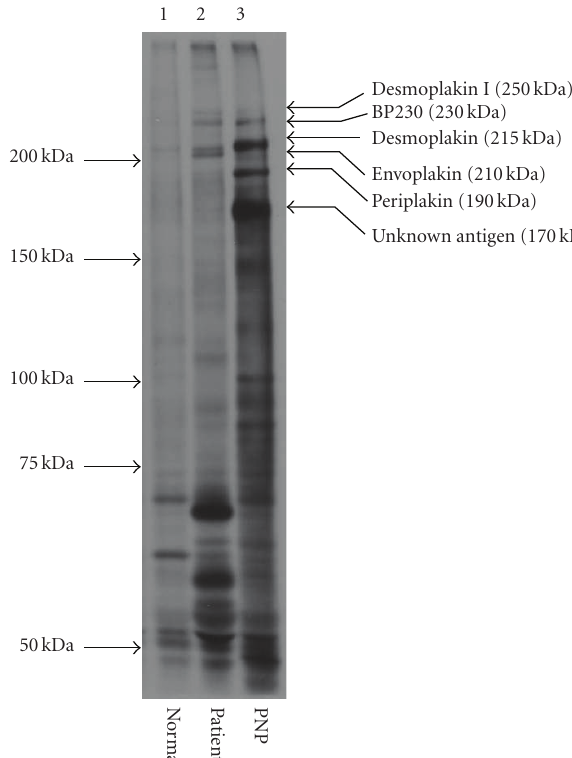
Figure 9: Results of immunoprecipitation using radiolabeled cultured keratinocytes. Control PNP serum (PNP) immunoprecip- itated the 250 kDa desmoplakin I, BP230, the 215kDa desmoplakin II, the 210 kDa envoplakin, the 190 kDa periplakin, and the 170 kDa unknown PNP antigen (lane 3). The serum of this patient (Patient) immunoprecipitated desmoplakin I, BP230 and envoplakin (lane 2). Normal control serum (Normal) showed no positive reaction (lane